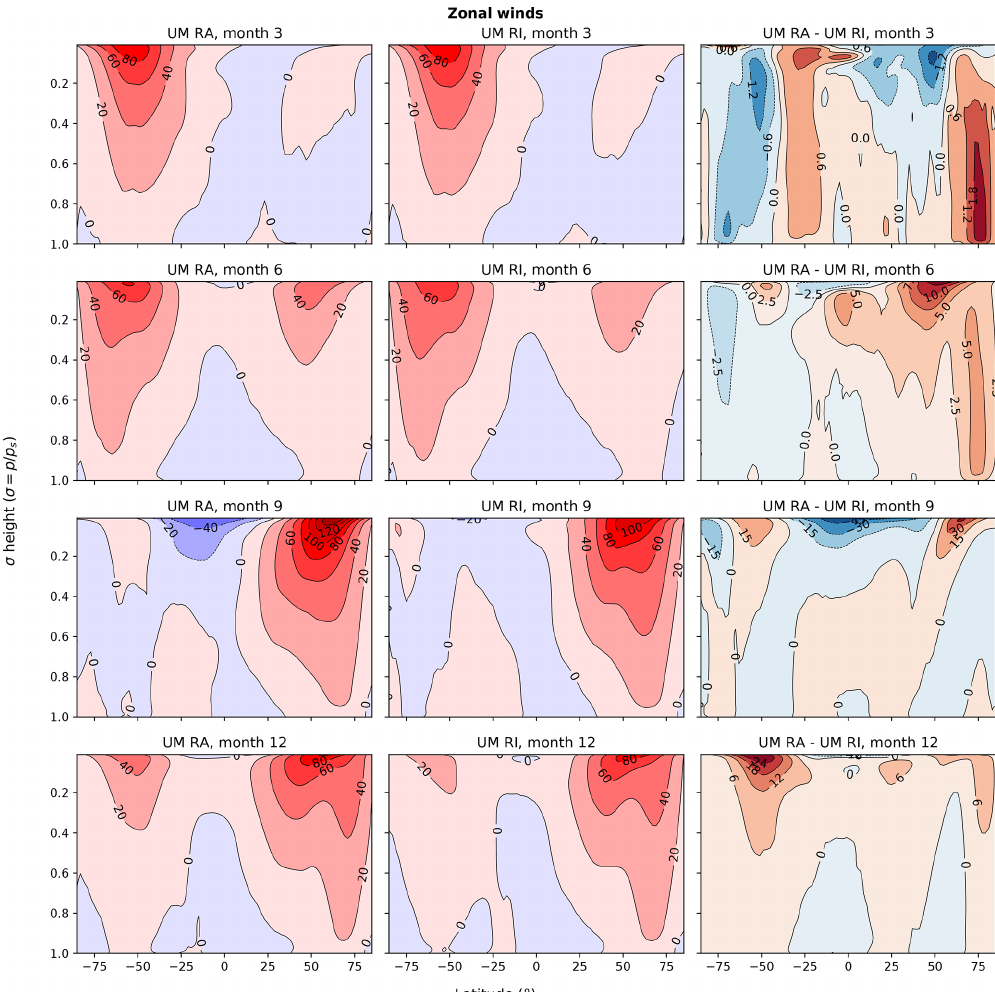
Figure A1. Zonal mean zonal winds (ms − 1 ) across four seasons within the Martian year. For each month, the time average is taken of all sols within that month. The RA dust scenario is shown on the left, the RI dust scenario in the centre and the differences between scenarios on the right. Colour scales in the left-hand and right-hand plots are matched across all months and between scenarios, with contour intervals of 20ms − 1 . The contours in the difference plots are not matched due to the varying intensity of the difference between months. Positive values indicate a northward wind and negative values a southward